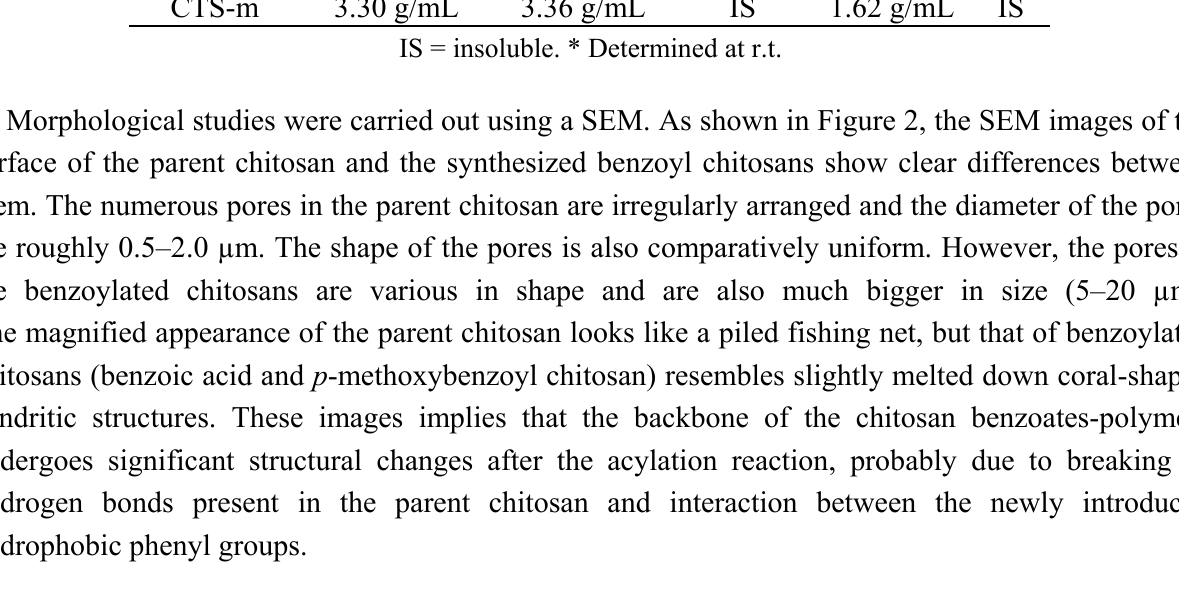
Figure 2. The SEM images of the parent chitosan and the synthesized benzoyl chitosans. The upper images: 25,000 times magnified images; The lower images: 5,000 times magnified images; Left: CTS; middle: CTS-b; right: